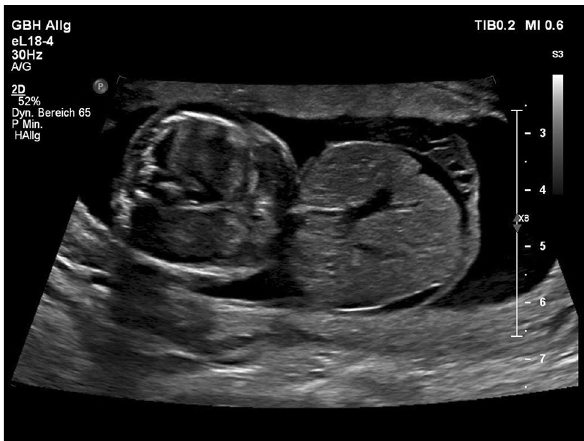
Figure 1. Big exomphalos with liver herniation.